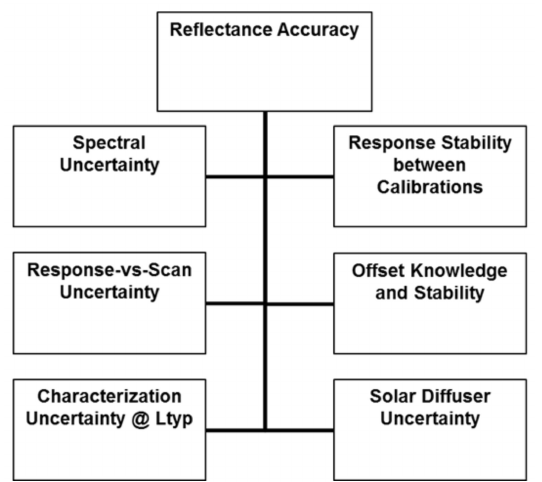
Figure 16. VIIRS top level radiometric calibration uncertainty